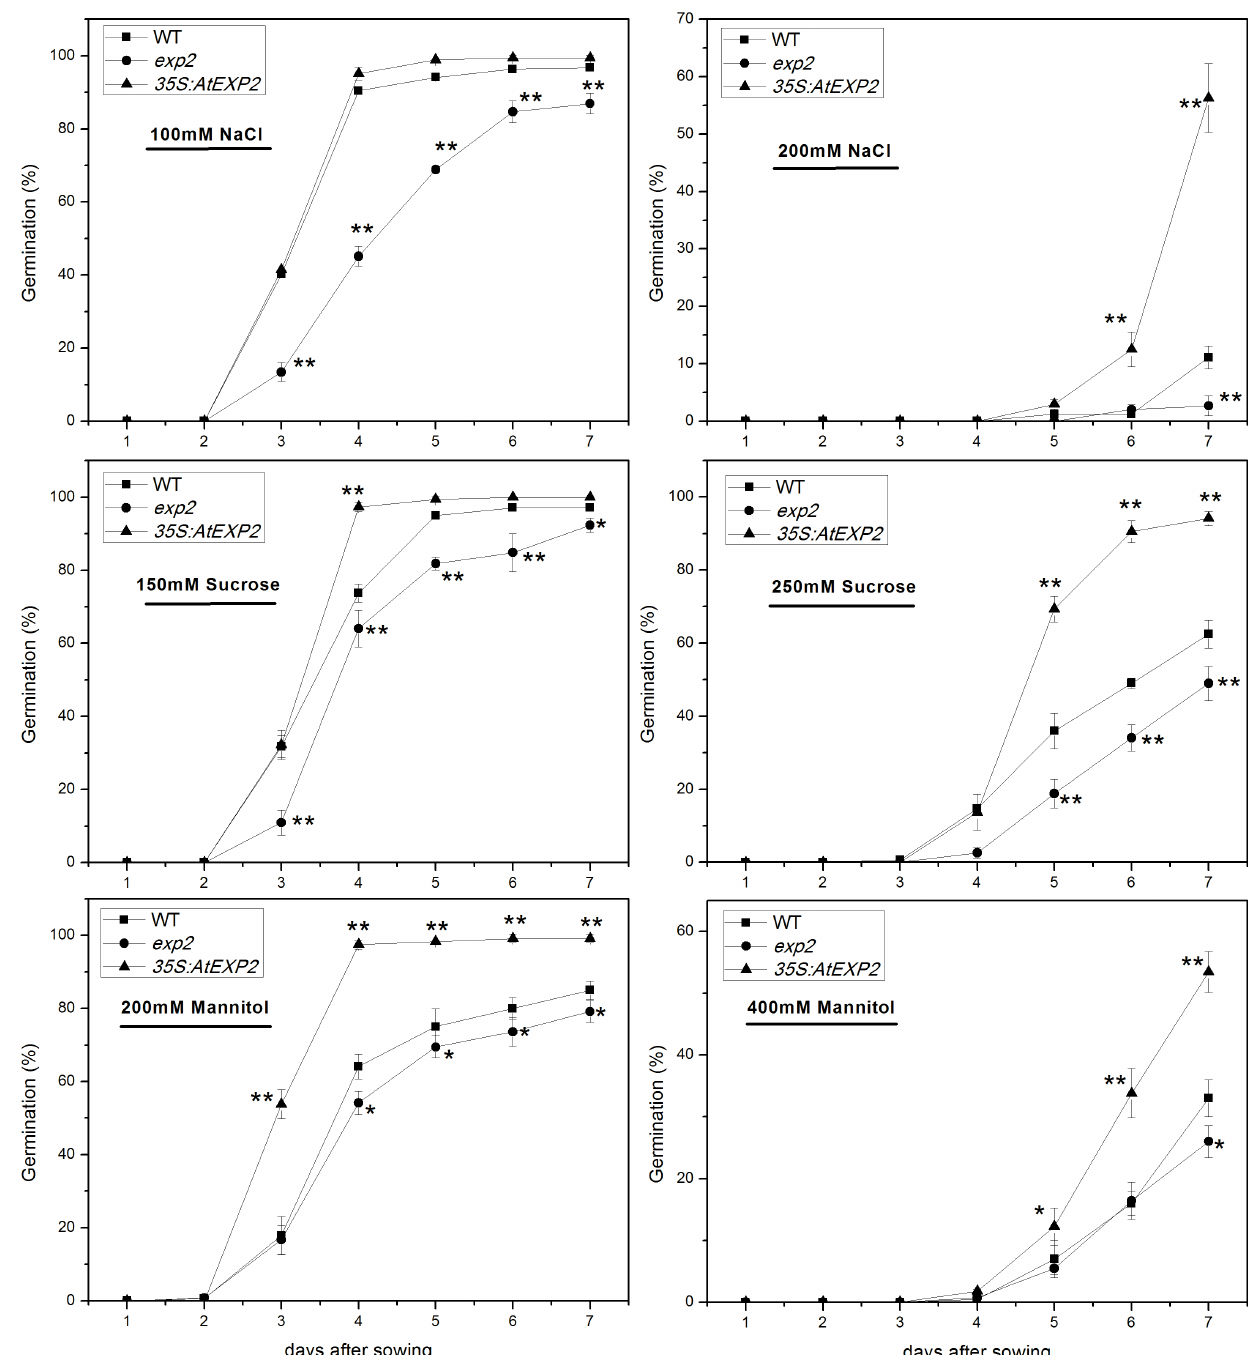
Figure 8. Germination phenotype of the wild type, exp2 , and 35S:AtEXP2 line in response to abiotic stresses. Seeds of wild type, exp2 and 35S:AtEXP2 line were treated with different concentrations of NaCl (100 or 200 mM), sucrose (150 or 250 mM) and mannitol (200 or 400 mM). Error bars represent SD. A Student’s t-test was calculated at the probability of either 5% (*P , 0.05) or 1% (**P , 0.01). doi:10.1371/journal.pone.0085208.g008 days after sown. In the high salt condition (200 mM), germination of all genotypes was severely affected, with less than 15% germination frequency in wild type, and less than 5% germination frequency in exp2 . Interestingly, the germination frequency of 35S:AtEXP2 line still reached approximately 60% seven days after